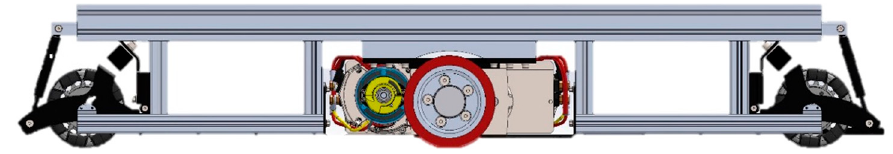
Figure 2. Lateral view of a vehicle frame with a drivetrain and drive system.